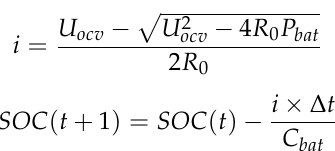
Figure 3. The battery internal resistance and the open circuit voltage (OCV) curve with respect to state of charge (SOC).